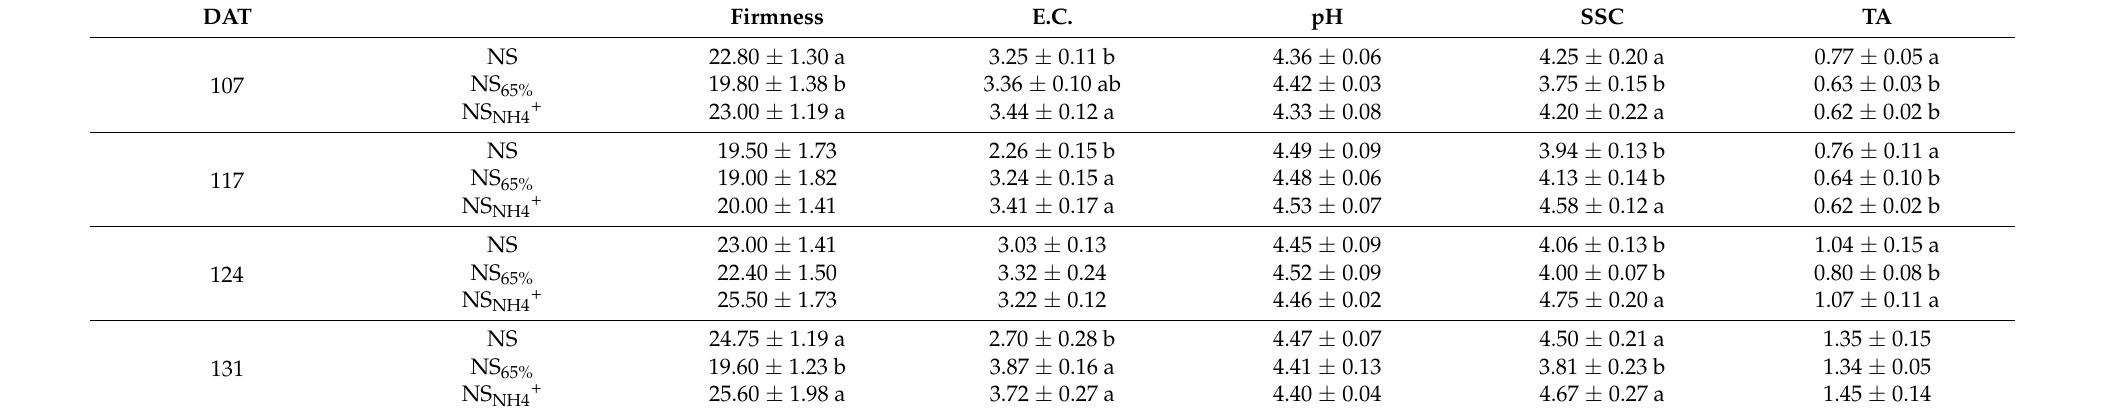
Table 3. Firmness (kg), EC (dS m − 1 ) total soluble solids content (SSC) ( ◦ Brix), juice pH, and titratable acidity (TA) (meq of citric acid L − 1 juice) in marketable fruits. The treatments were: (i) conventional fertigation (NS); (ii) 65 % of the fertilizers applied in conventional fertigation (NS 65% ); and (iii) with 20% of the total N applied in conventional fertigation being NH 4+ (NS NH4+ ). SSC means total soluble solids content and TA titratable acidity. Data are the means ± standard deviation of the samples ( n = 28) per treatment at the end of the trial. Means with different letters indicate significant differences among treatments at the p < 0.05 level by LSD